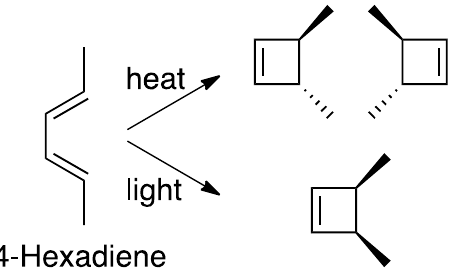
Figure 2. 2,4-hexadiene and the different products obtained via a heat- or light-induced process.